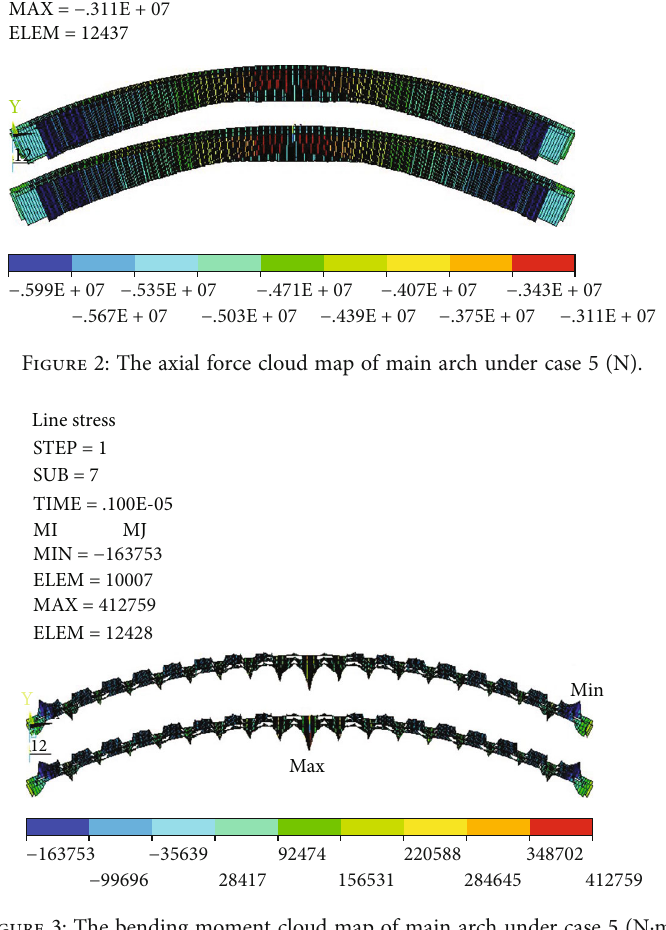
Figure 3: The bending moment cloud map of main arch under case 5 (N ·